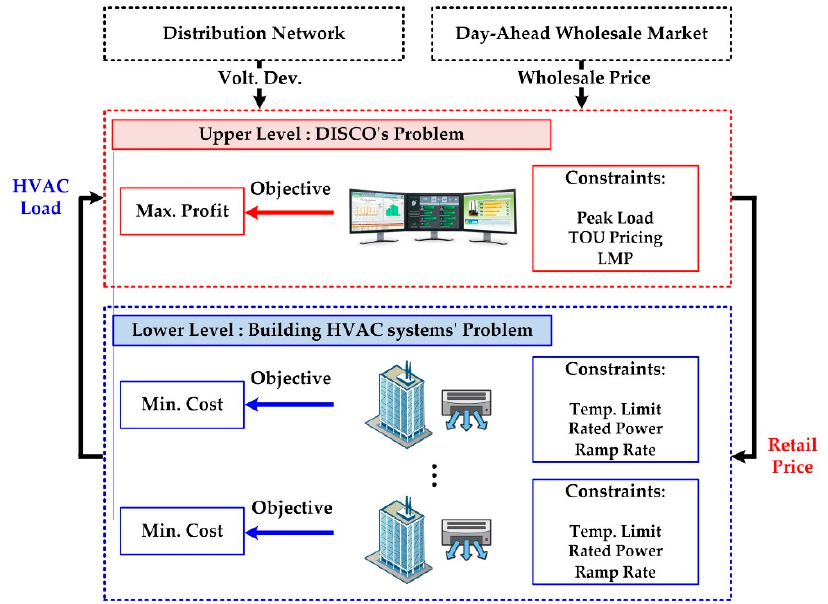
Figure 1. Overall framework of the proposed pricing strategy for heating, ventilating, and air-conditioning (HVAC) system.